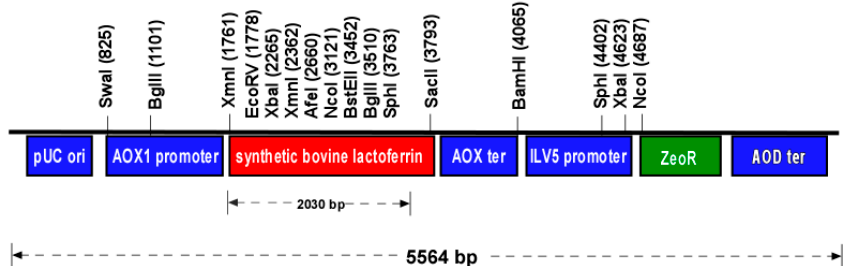
Figure 1. Restriction map of pJ902sbLf. The vector containing a synthetic bovine lactoferrin ( sbLf ) gene for expression in P. pastoris yeast. The ZeoR gene was also included as a selectable marker.